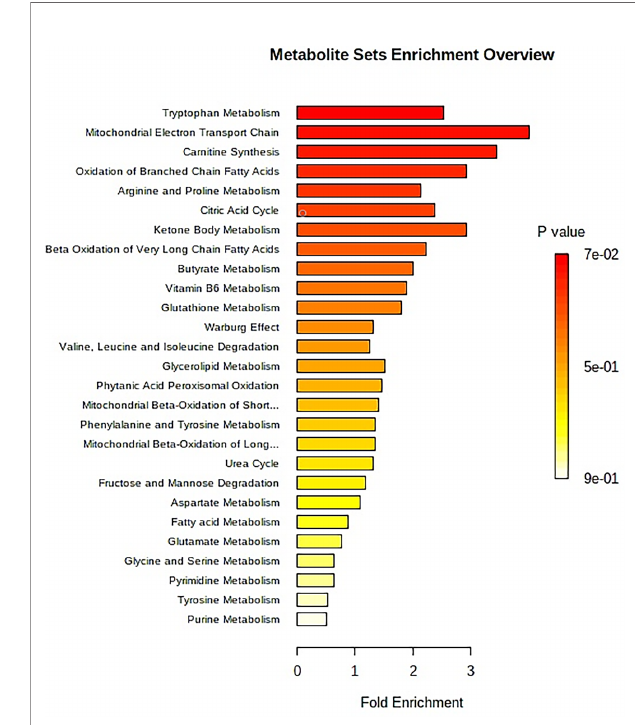
FIGURE 5 | The metabolite sets enrichment overview of urine samples for APCmin/+ mice. The enrichment analysis produces the predicted metabolite sets and key regulatory information to metabolic mechanism in this study. An overview of metabolite sets by the enrichment analysis is reported in Supplementary Table S2